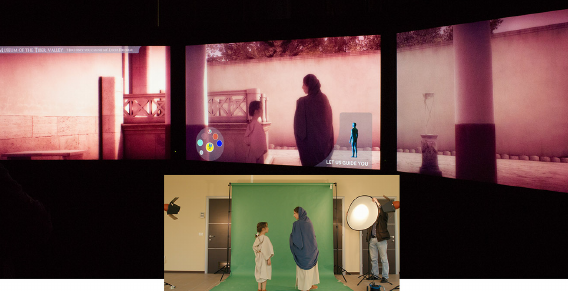
Figure 5. Virtual Museum of the Tiber Valley . Lucus Feroniae scenario, mixed